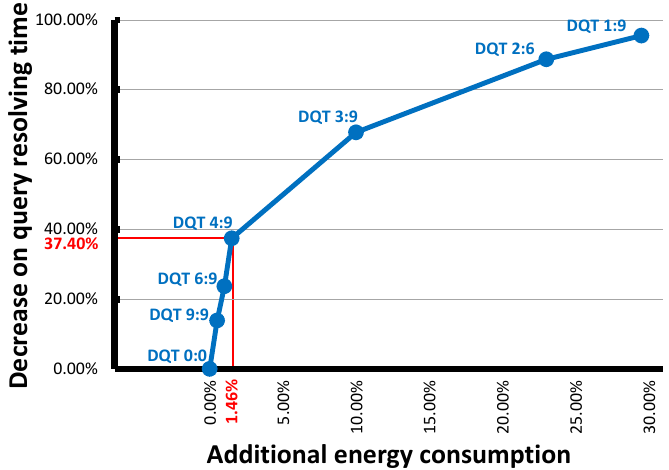
Figure 7. Running both Distributed Quad-Tree (DQT) and Geographic Hash Table (GHT) protocols as intra-island querying protocols of the Layered Federated Sensor Network (L-FSN) protocol. A data point label DQT n:m represent the DQT-GHT combination, where DQT protocol is running on islands of size n to m while GHT protocol is running on the rest of the islands. The size of islands in terms of gateways is given in Table